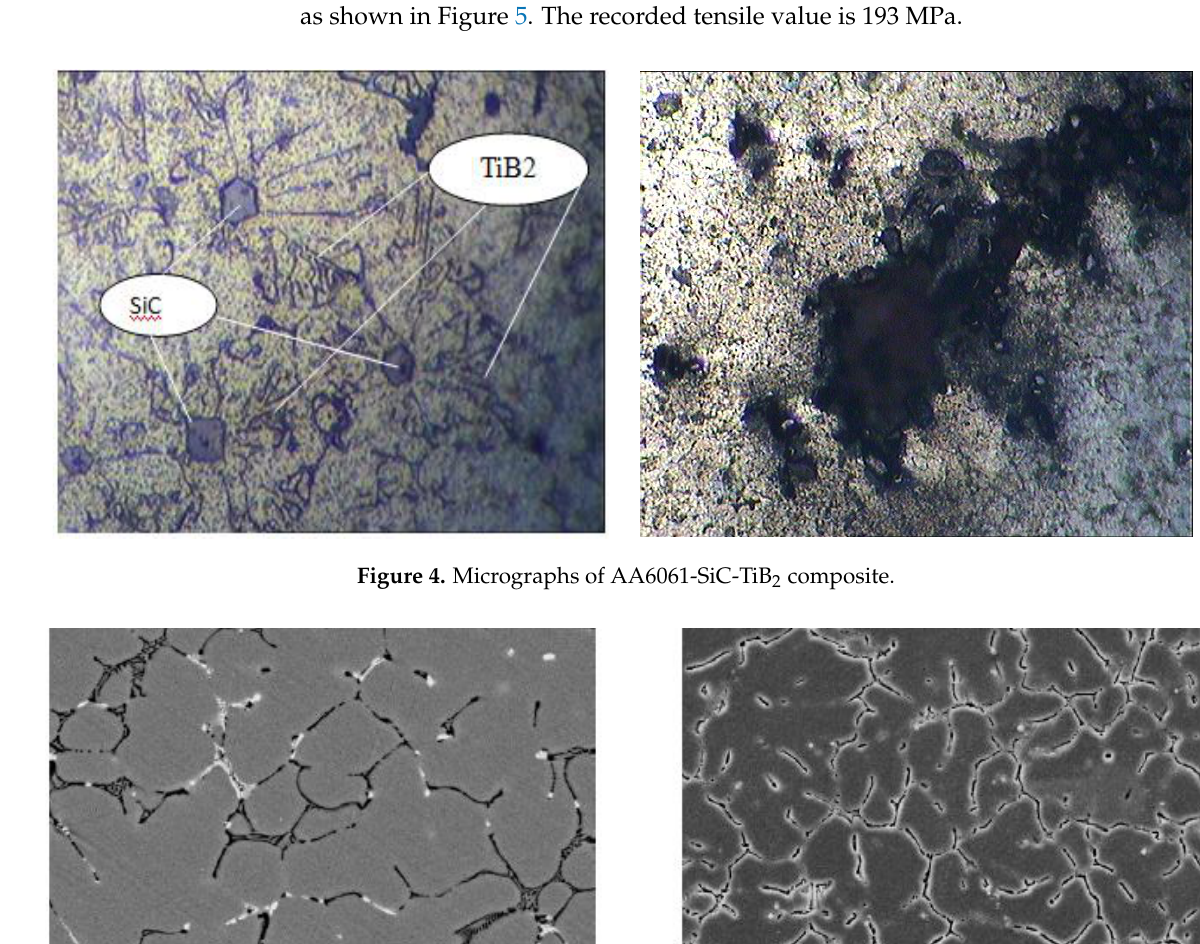
Figure 6. The micrographs of the A356-TiB 2 composite. A list of factors that influence the tensile value is mentioned and discussed in detail.